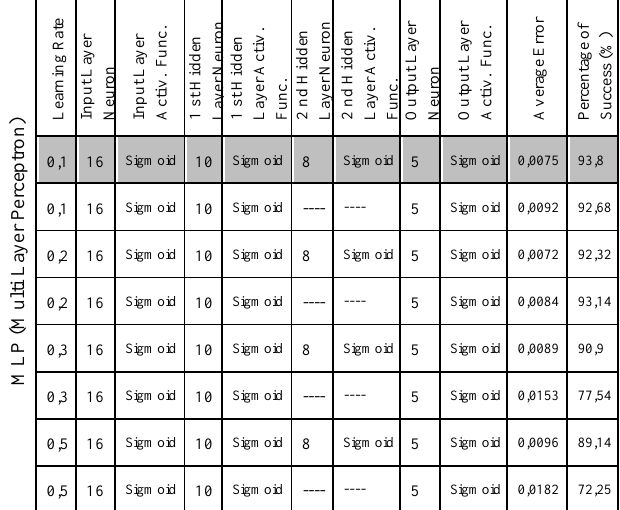
Table 9. The error value and percentage of success according to different MLP